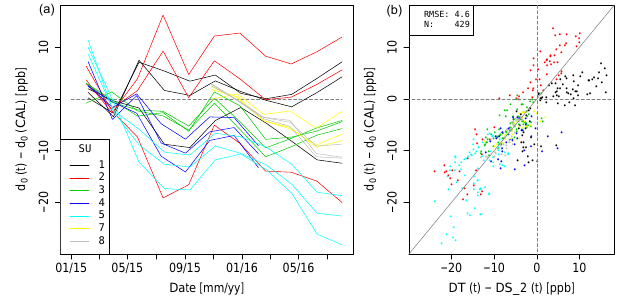
Figure 9. (a) Time series of the piecewise linear function d 0 of Eq. (6) (DS 3: calibration PAR/REM) with the average d 0 value during the initial calibration phase subtracted. (b) Comparison of the values from (a) with the difference between fortnightly NO 2 concentrations from diffusion tubes (DT) and measurements from the NO 2 sensors (DS 2: Eq. 6 with d 0 = const, calibration PAR). The depicted solid line shows the 1:1